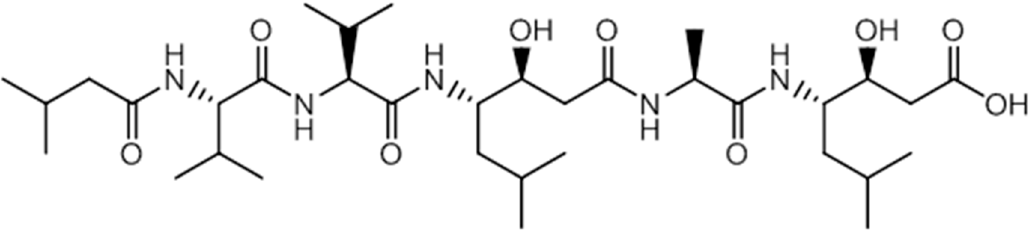
Figure 3. Chemical structure of the pepstatin A (C 34 H 63 N 5 O 9 , Mw = 686 g·mol − 1 ).